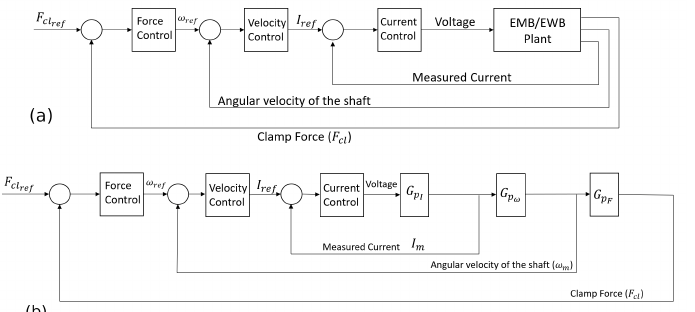
Figure 3. Cascaded control scheme for the EMB/EWB ( a ); The bottom Figure shows the decomposed system for control design ( b ).